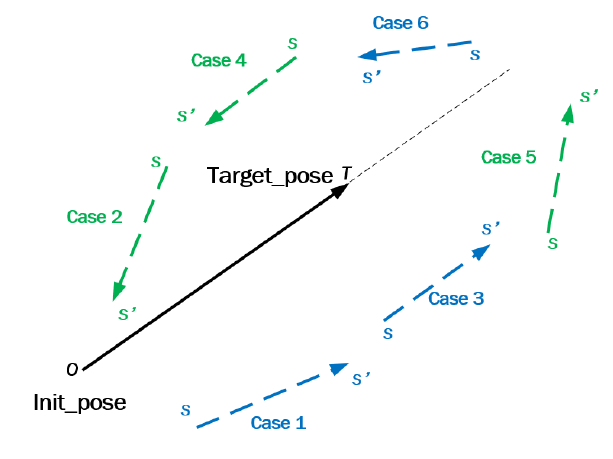
Figure 2. Six steps of the Step-by-Step Reward